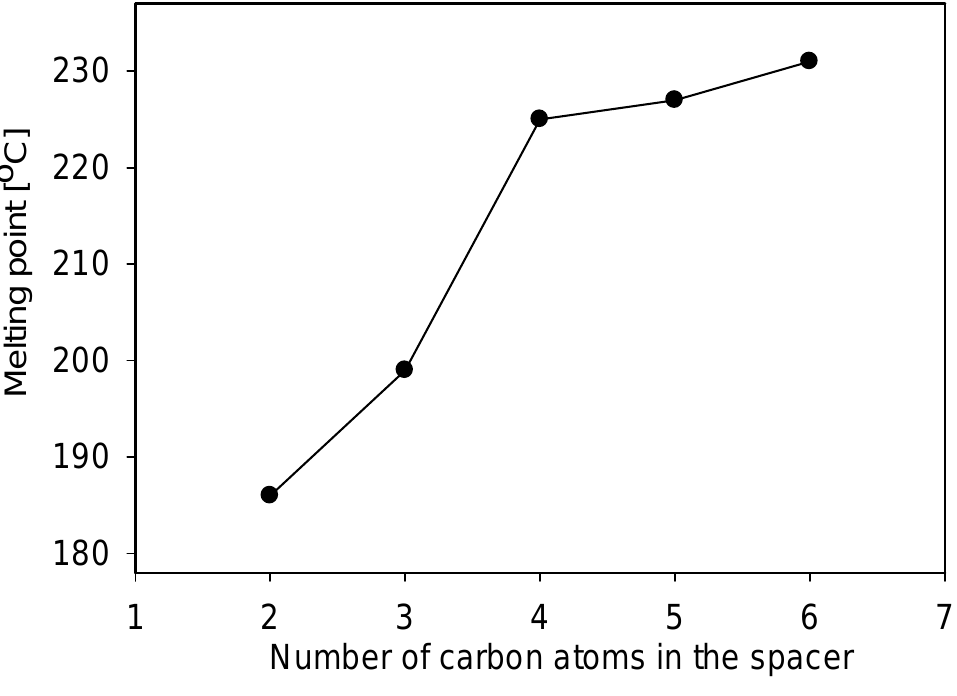
Figure 1. The relationship between melting points of 1-5 and number of carbon atoms in the